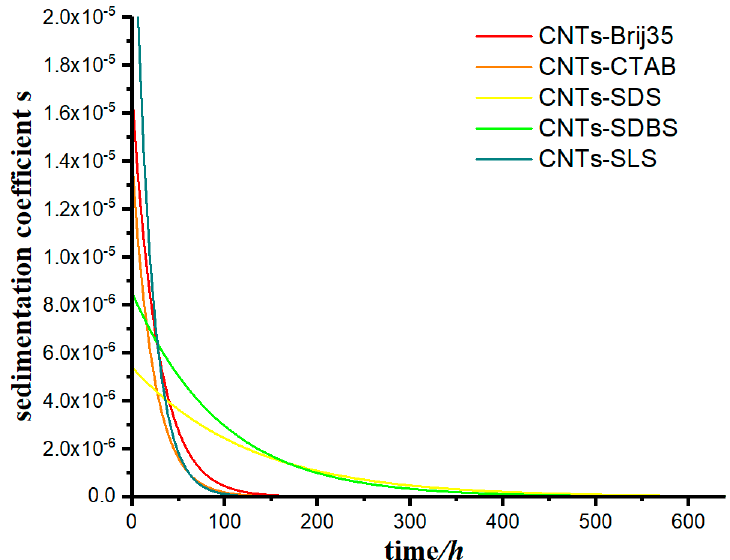
Figure 11. The change in the sedimentation coefficient of carbon nanotube suspension as a function of time for various flocculants.